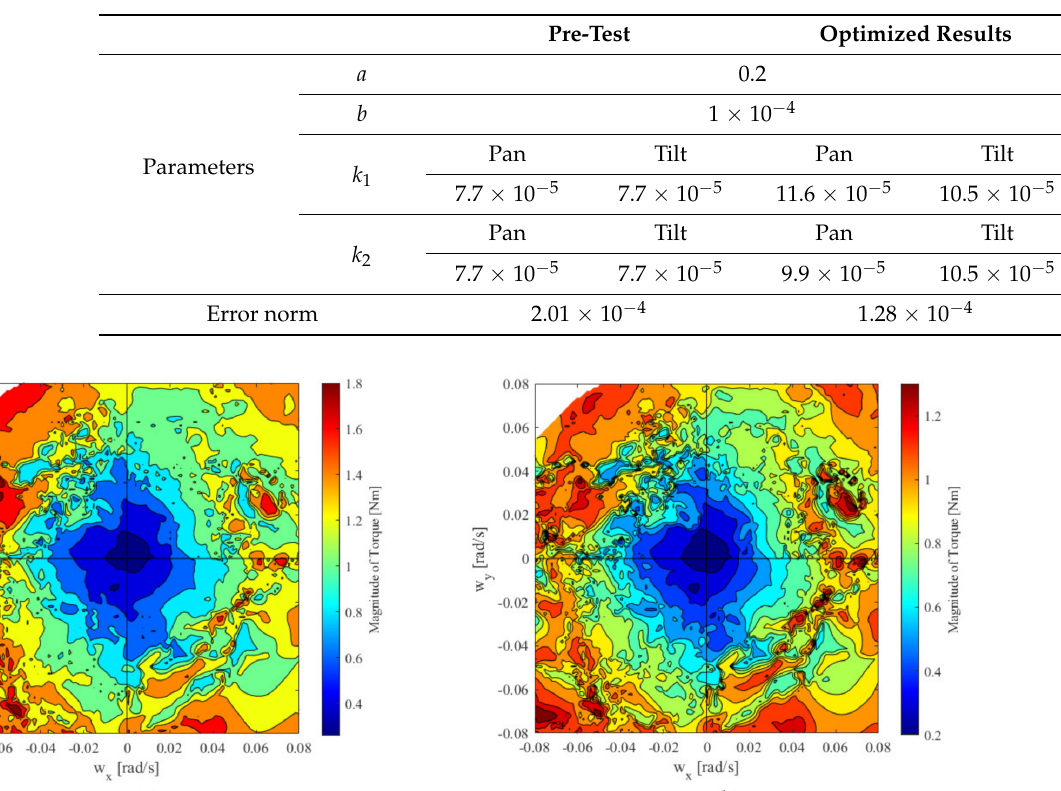
Table 2. Parameters of the command generation function.